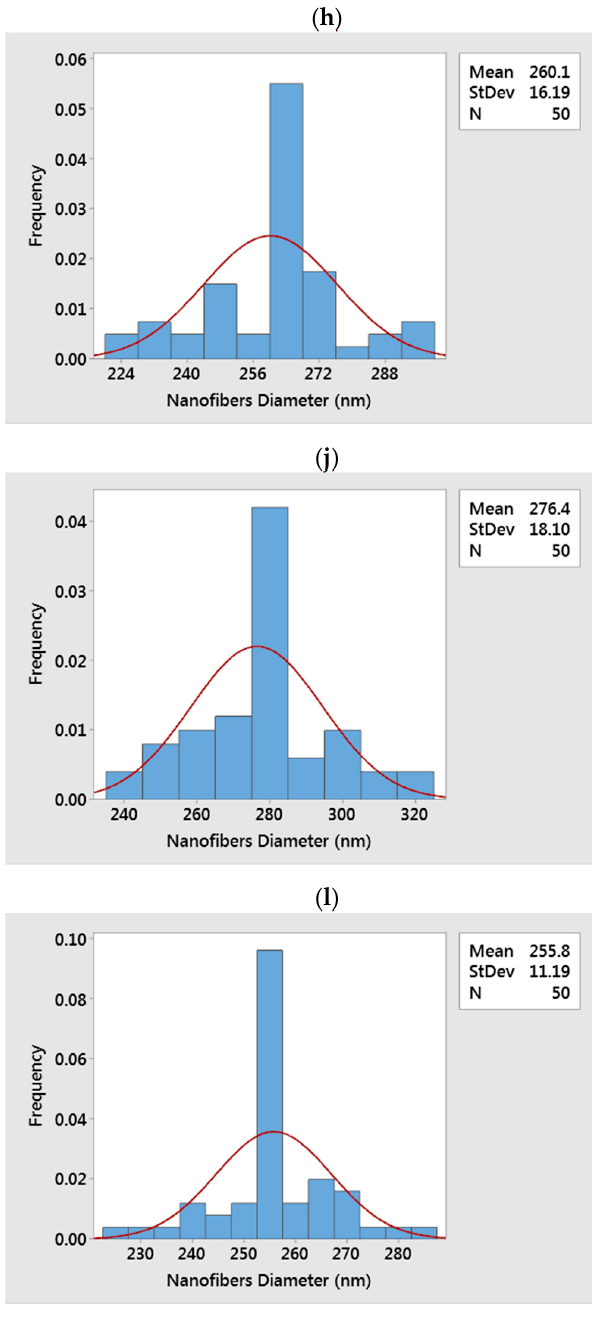
Figure 2. SEM micrographs and nanofibers diameter distribution corresponding to the experimental run numbers in Table 3, as follows: ( a , b ) 3, ( c , d ) 13, ( e , f ) 14, ( g , h ) 18, ( i , j ) 29, and ( k , l ) 36.